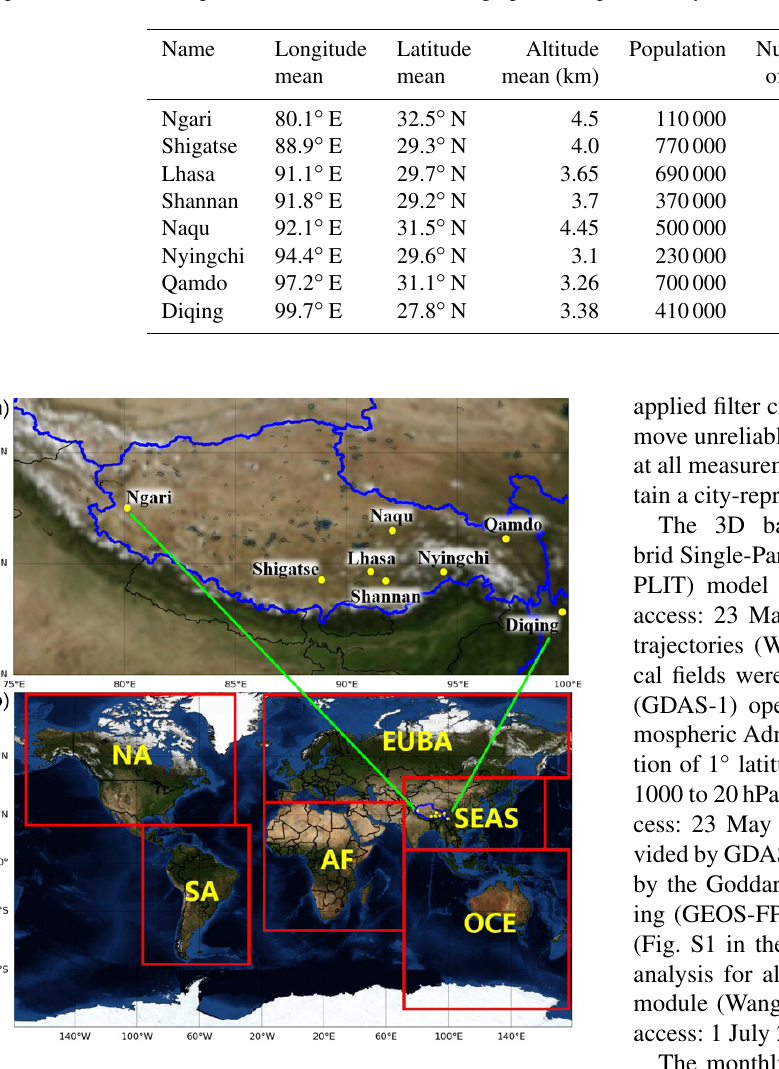
Table 1. Geolocations of measurement sites in eight cities over the HTP region. All sites are organized as a function of increasing longitude. Population statistics are prescribed from the 2018 demographic data provided by National Bureau of Statistics of China.